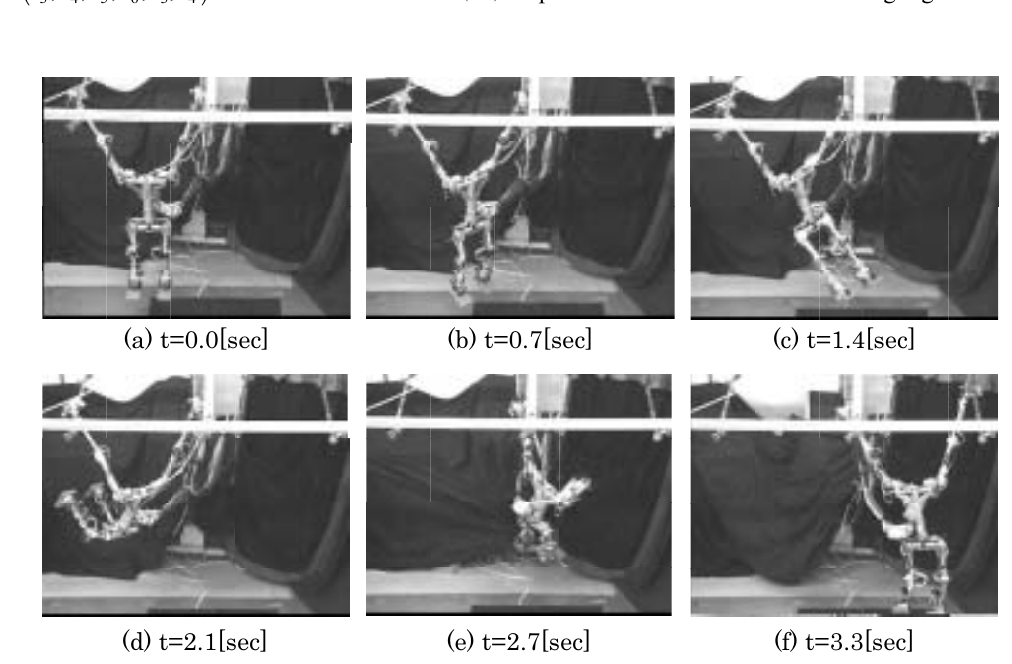
Figure 16 Stroboscopic photography of over-hand